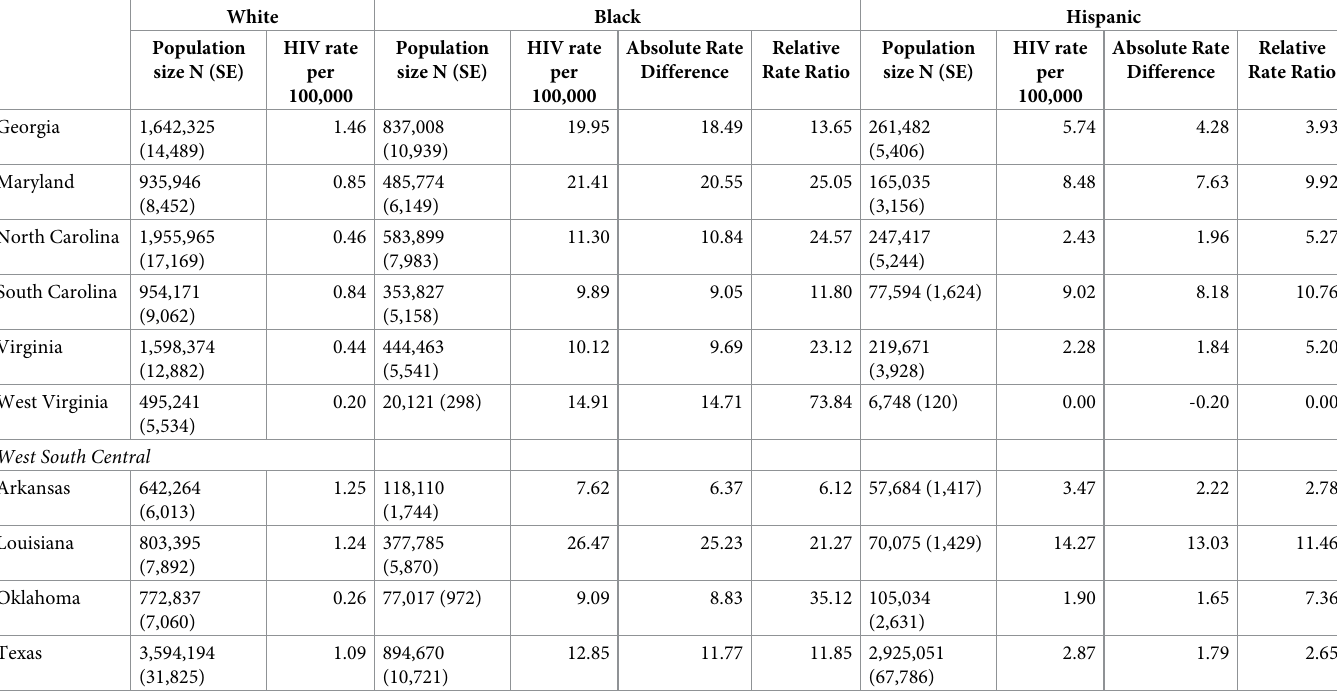
races”). The HIV diagnosis rates stratified by race and ethnicity were 0.76, 16.16, and 3.55 per 100,000 HAA White, Black, and Hispanic men, respectively. Black-to-White and Hispanic-to- White RDs were 15.40 and 2.79, respectively. Black-to-White and Hispanic-to-White RRs were 21.28 and 4.68, respectively. Across states and the District of Columbia, HIV diagnosis rates among HAA men ranged from 0.00 to 3.18 among 100,000 White HAAs (median: 0.42), from 0.00 to 48.67 per 100,000 Black HAAs (median: 10.12), and from 0.00 to 14.27 100,000 Hispanic HAAs (median: 2.27). Black-to-White and Hispanic-to-White RDs among HAA men ranged from -0.88 to 45.49 (median: 9.69) and from -0.88 to 13.03 (median: 1.84), respec- tively. Black-to-White and Hispanic-to-White RRs among HAA men ranged from 0 to 81.48 (median: 20.58) and from 0 to 20.59 (median: 5.20), respectively. Comparing census regions, HIV diagnosis rates among White HAA men were highest in the South (1.15 per 100,000 HAA men), followed by the Northeast (0.68 per 100,000 HAA men), West (0.55 per 100,000 HAA men), and Midwest (0.39 per 100,000 HAA men). Similar to White men, Black men had the highest HIV diagnosis rates in the South (19.42 per 100,000 HAA men); however, the rank ordering of the three other regions differed between Black